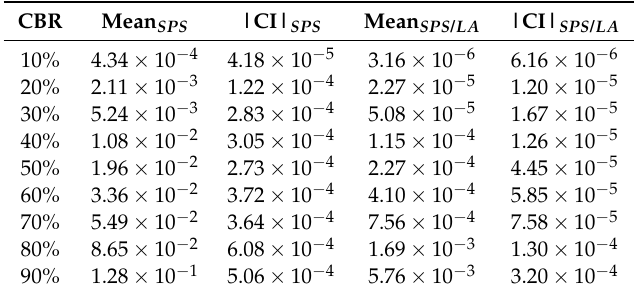
Table 4. Collision probability at t = 100 with 95% confidence interval (CI)